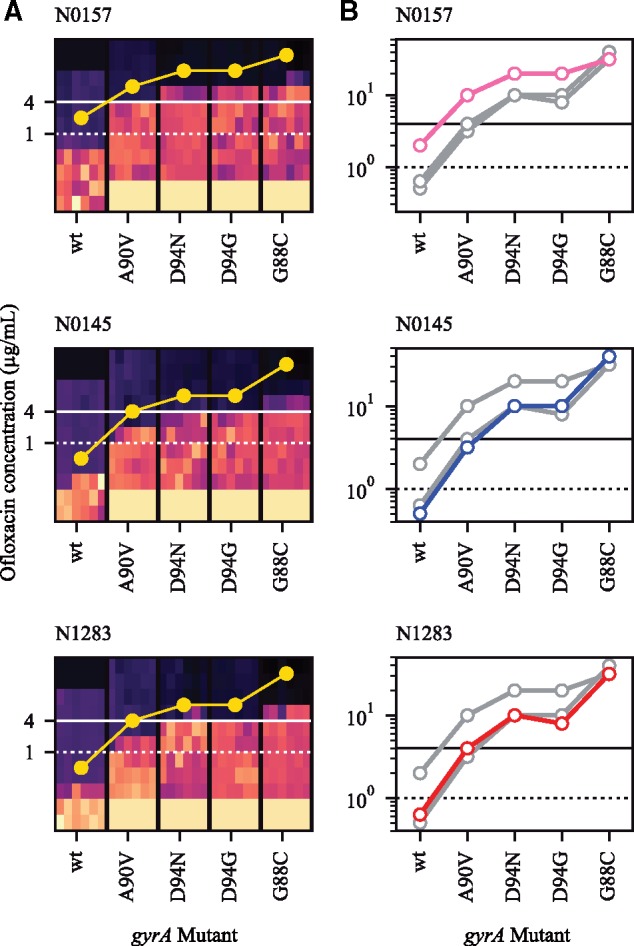
The Mycobacterium tuberculosis genetic background modulates the ofloxacin (OFX) minimum inhibitory concentration (MIC). (A) Heat-map of OFX-susceptibility via Alamar Blue assay for gyrA mutant strains of Mtb, as well as their wild-type ancestor, in three genetic backgrounds (N0157, N0145, or N1283). Light areas represent growing cultures, while dark areas represent nongrowing cultures. Yellow points represent estimates for OFX MIC (≥95% reduction in fluorescence). Areas of solid black colors (at 16+ μg/ml OFX for wild-type) and solid light beige colors (at <0.125 μg/ml OFX for mutants) were not measured and colored in for illustrative purposes. (B) OFX MIC estimates for each strain per genetic background, superimposed. Colored points and lines represent MIC measurements for highlighted genetic background, with the line color denoting the lineage that the strain belongs to (L1, pink, L2, blue, L4, red). Gray points and lines represent the other two genetic backgrounds. Solid horizontal black line denotes 4 μg/ml OFX, while dashed horizontal black line denotes 1 μg/ml OFX.